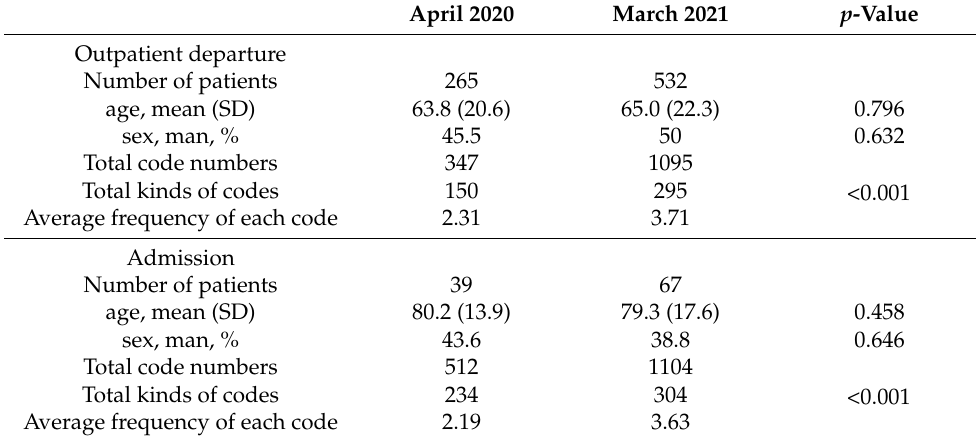
Table 1. Patients’ demographics and the numbers and kinds of ICD-10 codes.